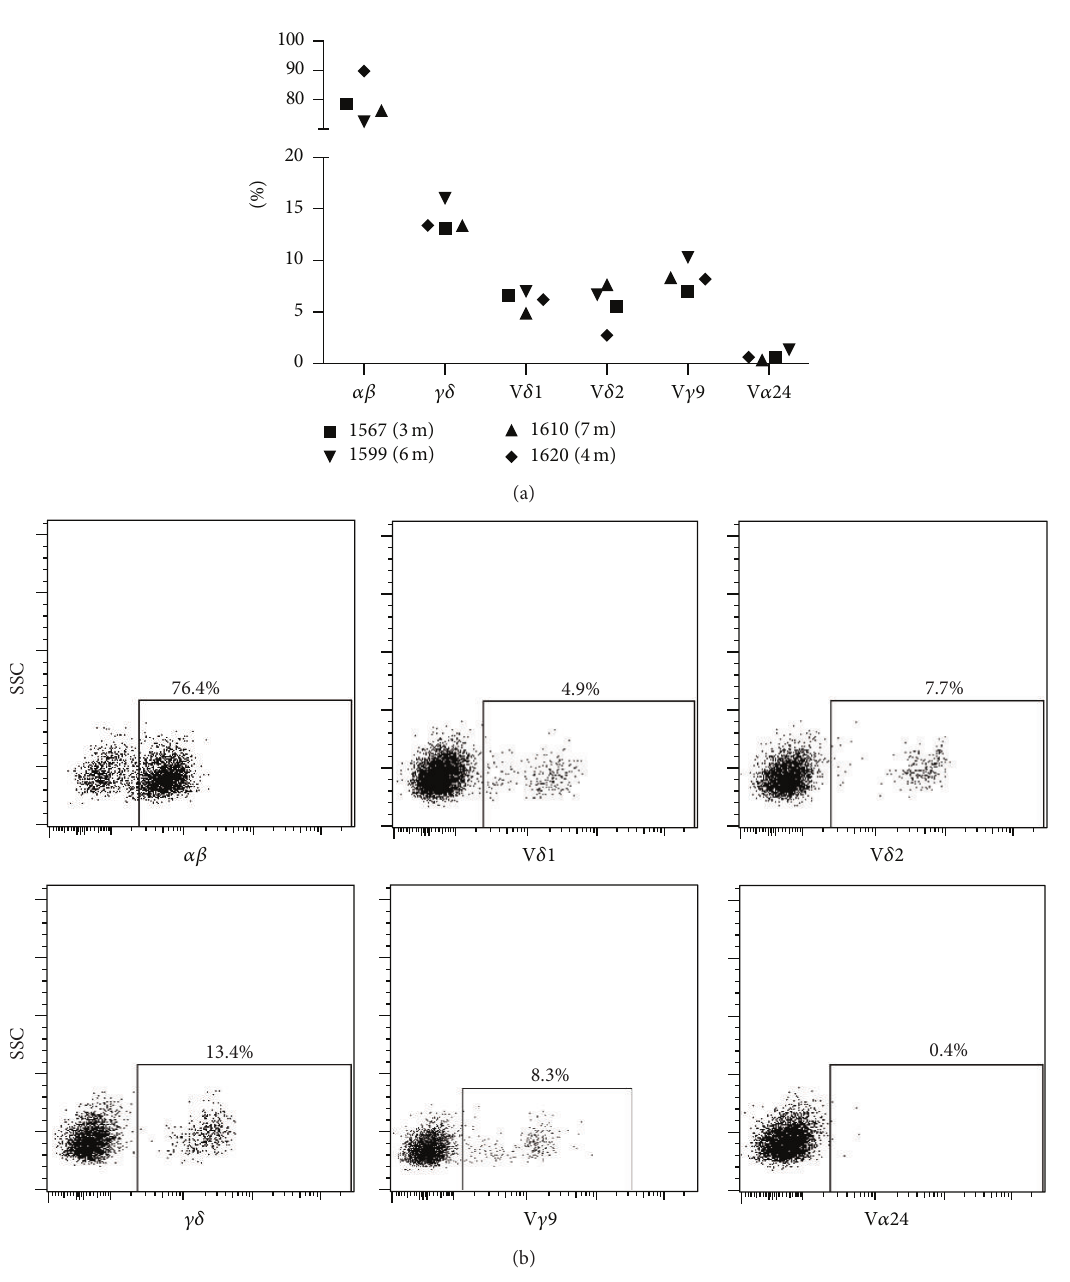
Figure 5: 𝛾𝛿 subsets in PBMC > 3 months after boost. Blood samples were taken 3–7 months (m) after boost from four patients. (a) Subgroups ( 𝛼𝛽 , 𝛾𝛿 , V 𝛿 1, V 𝛿 2, V 𝛾 9, and V 𝛼 24)+ cells of CD3+ T-cells from PBMCs were analyzed. (b) Representative plots of the subsets 𝛼𝛽 , 𝛾𝛿 , V 𝛿 1, V 𝛿 2, V 𝛾 9, and V 𝛼 24+ cells of CD3+ T-cells from patient 1610, 7 months post